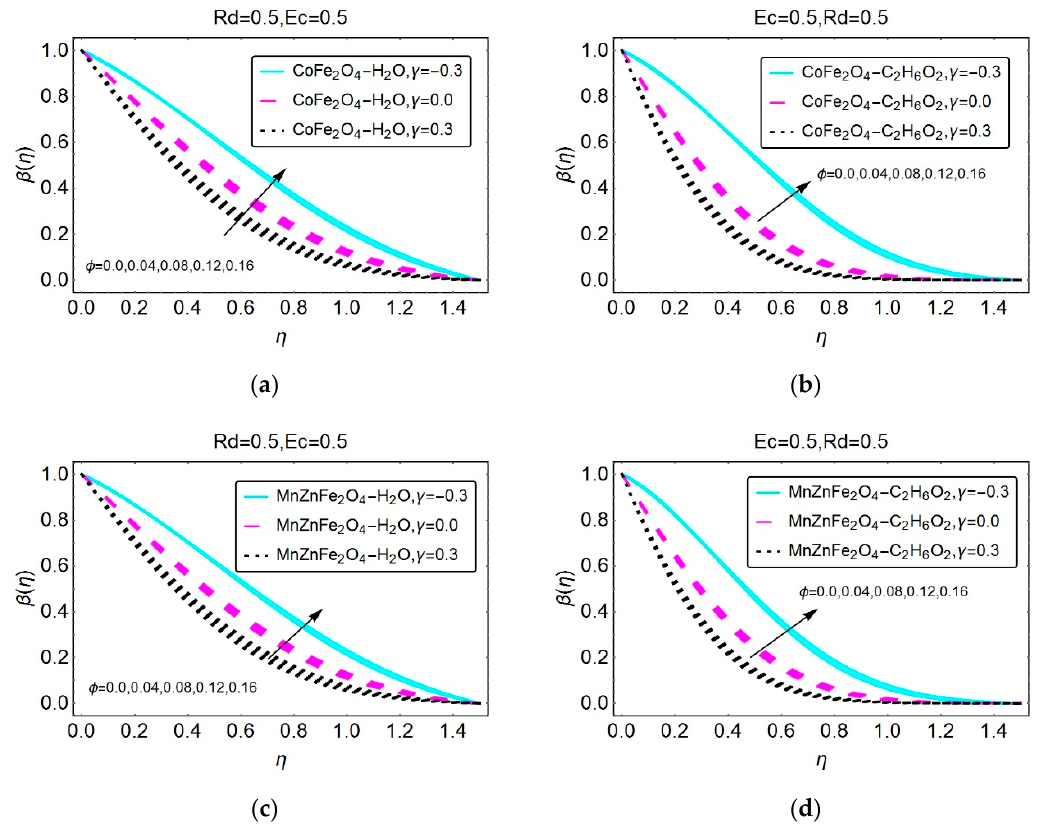
Figure 6. Alterations in the temperature distribution for ( a ) CoFe 2 O 4 − H 2 O; ( b ) CoFe 2 O 4 − C 2 H 6 O 2 ; ( c ) MnZnFe 2 O 4 − H 2 O; ( d ) MnZnFe 2 O 4 − C 2 H 6 O 2 nanofluids by varying φ